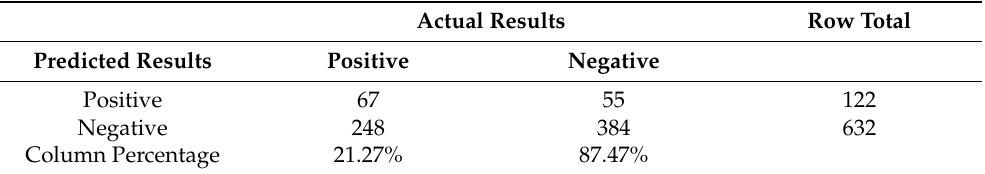
Table 8. SVM classifier result one.